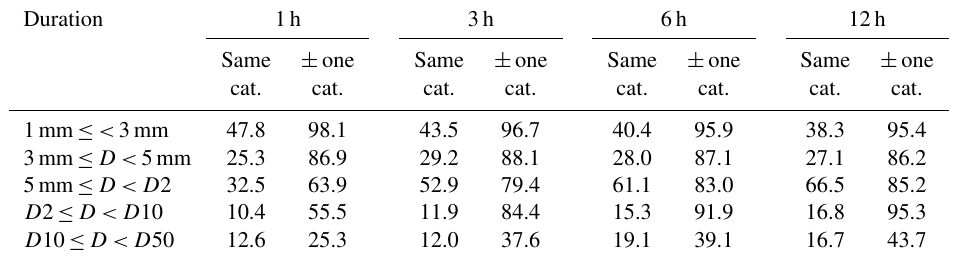
Table 1. Fraction (%) of time steps where the D -category of the automatic station either agrees with the one of HIPRAD3 (column “same cat.”, equivalent to hit rate) or is within ± one D -category (column “ ± one cat.”), for durations 1, 3, 6 and 12h. Duration 1h 3h 6h 12h Same ± one Same ± one Same ± one Same ± one cat. cat. cat. cat. cat. cat. cat. cat.